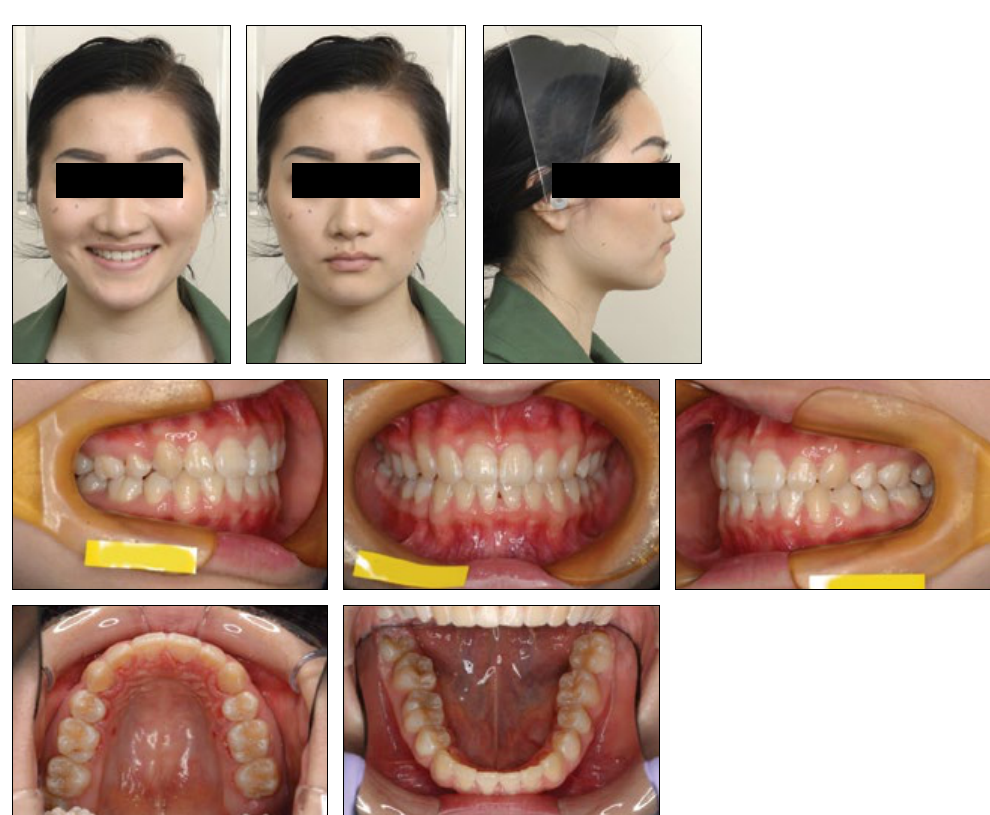
Figure 9. Post-treatment facial and intraoral photographs.